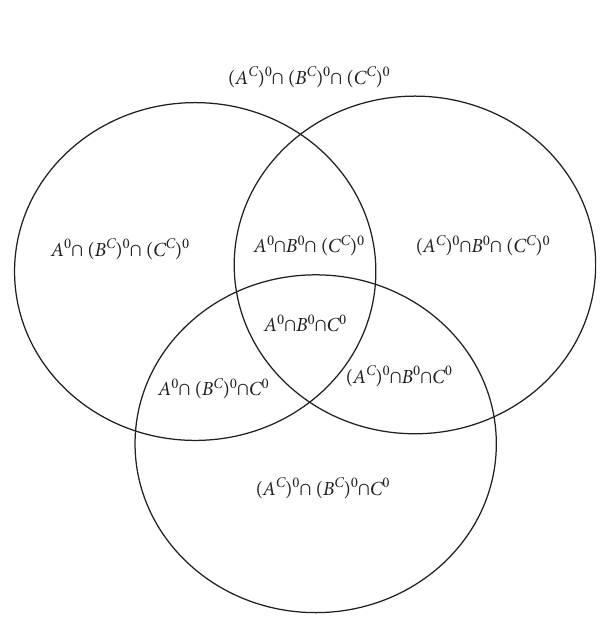
Figure 2: The spatial partition of three simple areas.